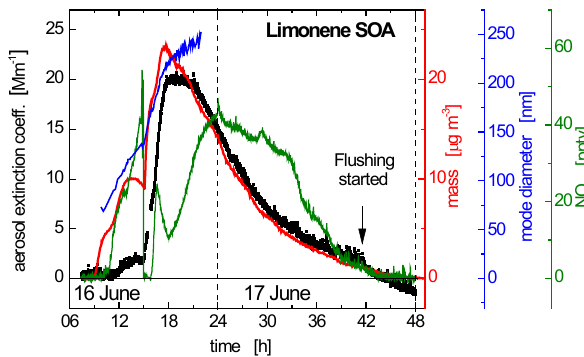
Fig. 2. IBBCEAS measurement of the extinction coefficient of SOA at 687nm (black dots) formed by NO 3 oxidation of limonene on 16–17 June 2007. Reactants were added to the chamber on 16 June at 06:20 (30ppbv NO 2 ) , 06:26 (10ppbv limonene), 08:50 (50ppbv O 3 ), and 14:30 (30ppbv O 3 , 30 ppbv NO 2 , 10ppbv limonene). To- tal aerosol mass (red) and mode diameter (blue, scaled) from the AMS are also shown. Continuous flushing of the chamber com- menced shortly before 18:00 on 17 June, leaving a particle-free chamber by